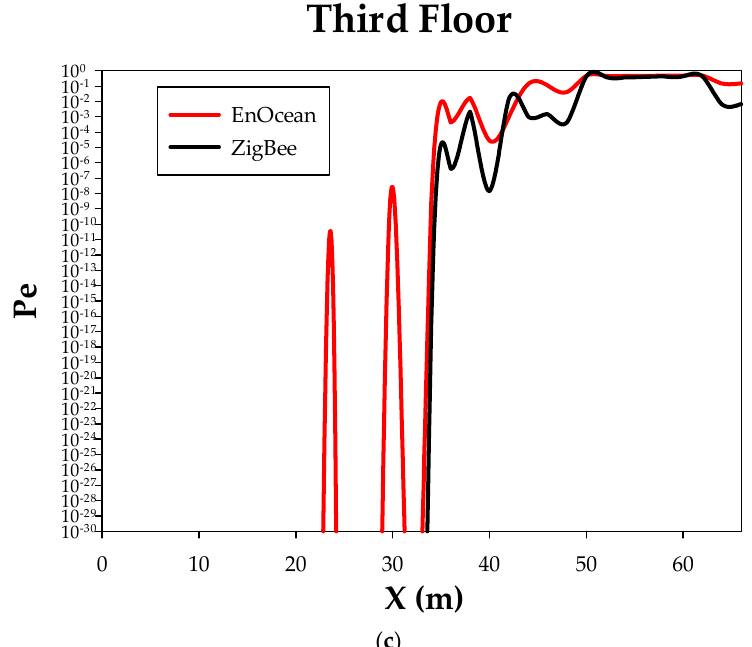
Figure 9. Performance comparison between EnOcean and ZigBee in terms of BER for the linear path depicted in Figure 5. ( a ) First floor; ( b ) Second floor; ( c ) Third floor.